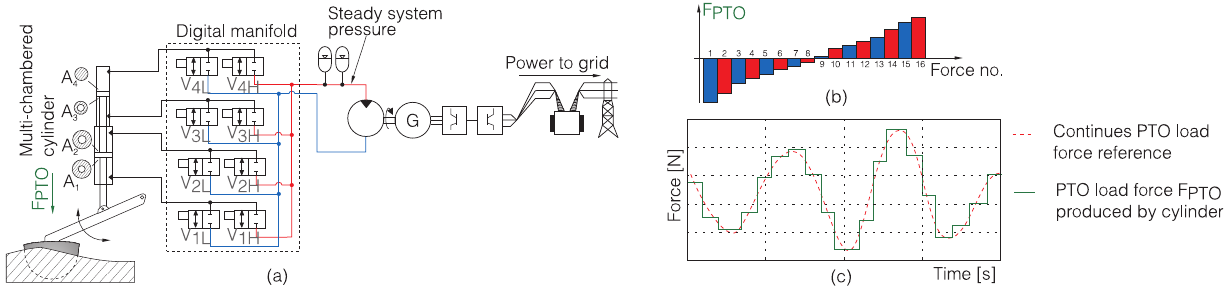
( a ) the discrete PTO system based on discrete displacement control of a multi-chambered cylinder (Discrete Displacement Cylinder (DDC)-system); ( b ) the forces, , the PTO may produce; and ( c ) how F is discretely varied using the DDC-system F PTO PTO during a